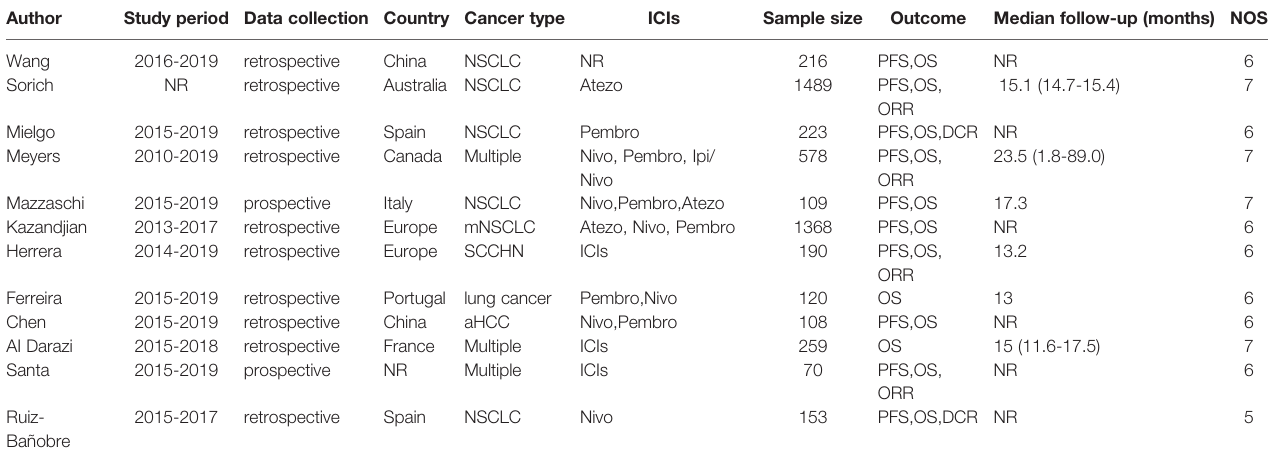
TABLE 1 | The characteristics of included